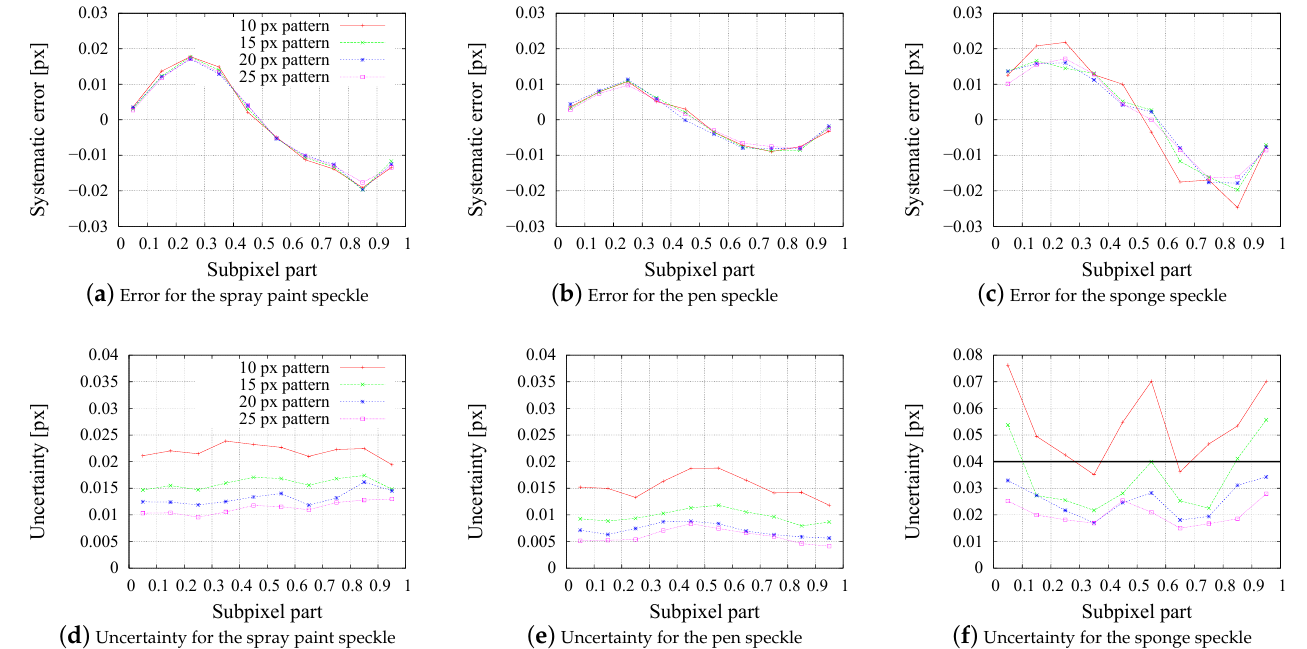
( b ) Error for the pen speckle ( c ) Error for the sponge speckle